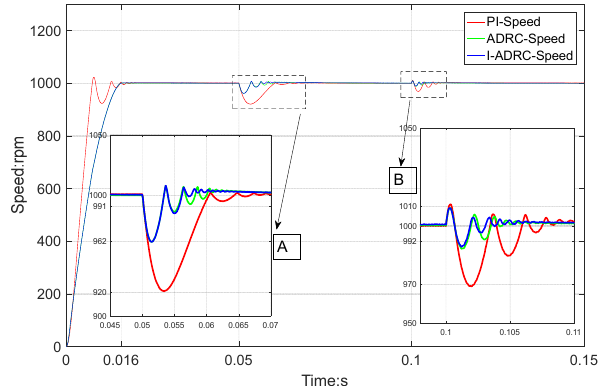
Figure 5. Speed simulation